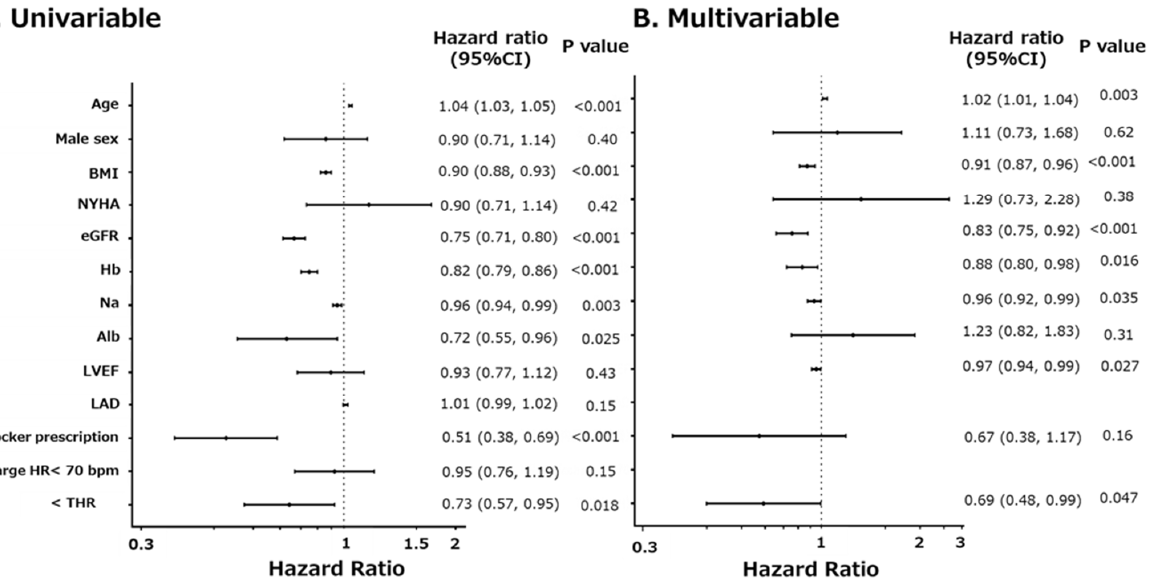
Figure 2. Kaplan-Meier curves for ( A , B ) the primary endpoint, ( C , D ) all-cause death, and ( E , F ) ADHF readmission dividing the study population according to discharge HR by a cutoff of THR or 70 bpm. The primary endpoint was defined as a composite of all-cause death and ADHF readmission. ADHF: acute decompensated heart failure, discharge HR: heart rate at discharge, THR: target heart rate.